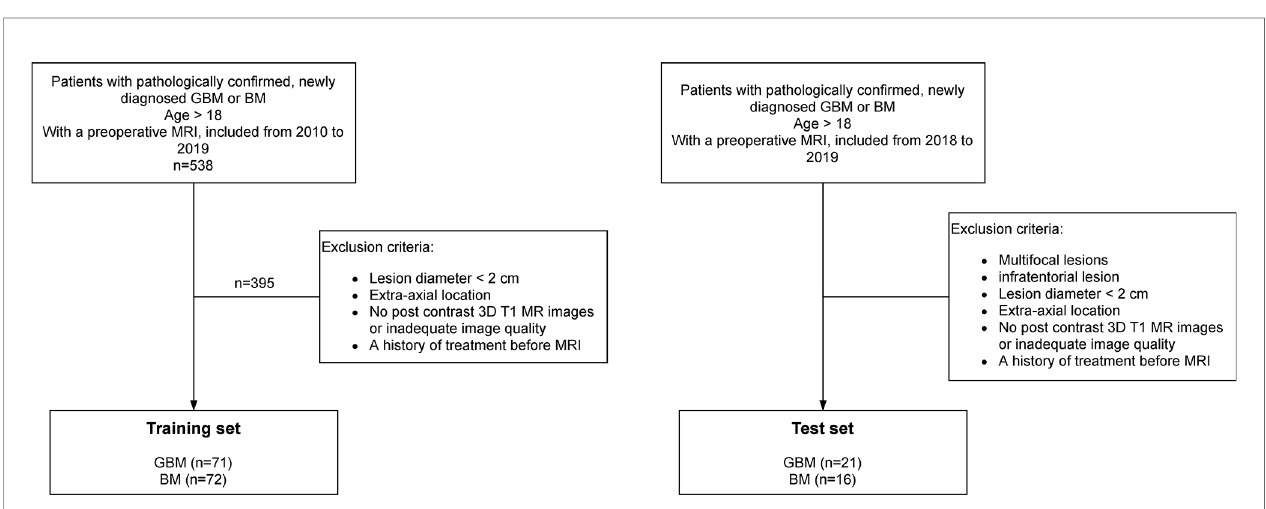
FIGURE 2 | Flow chart of patient inclusion.